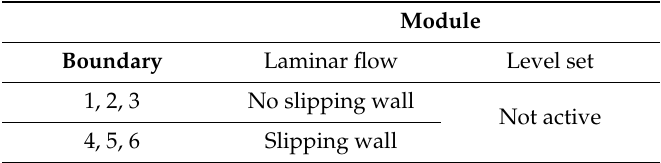
Table 2. The boundary conditions of the model.